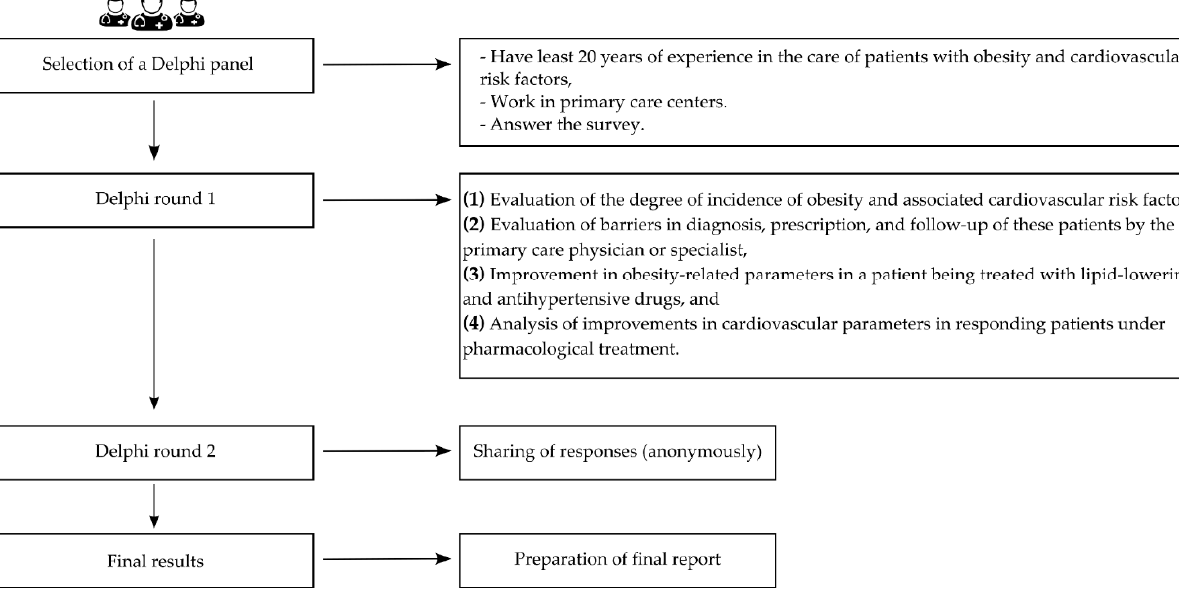
Figure 1. Delphi design study flow chart.